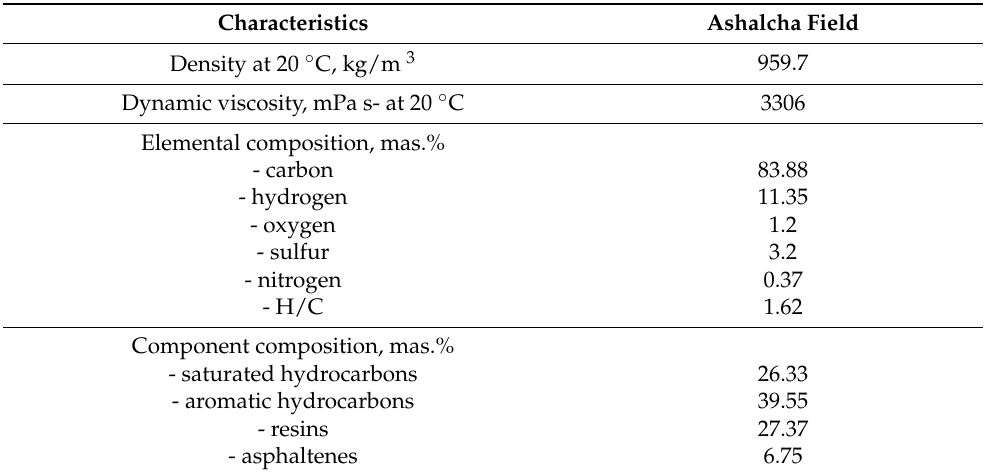
Table 3. - Physical and chemical properties of the initial